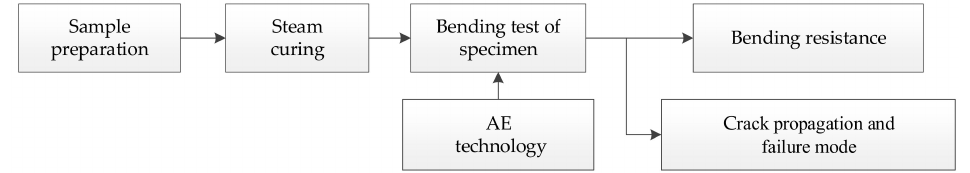
Figure 6. Experimental procedure.